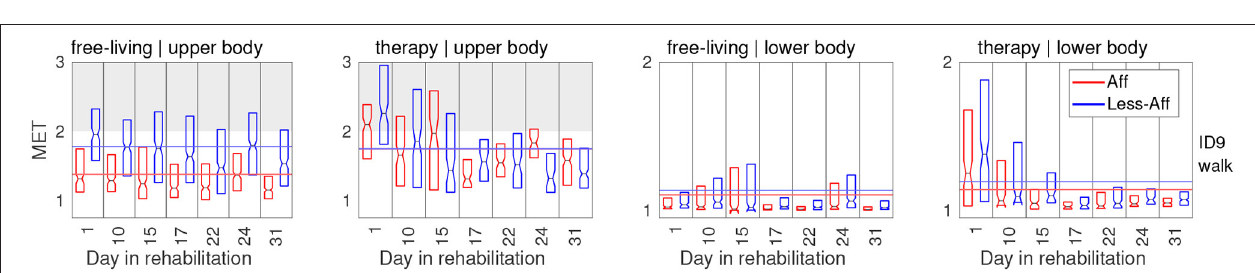
FIGURE 5 | Histograms of PA in MET equivalents for affected and less-affected upper and lower body for patient ID9. The distribution show PA derived from free-living and therapy during the complete rehabilitation period of patient ID9. PA distributions show a positive skew, indicating mostly light intensity, corresponding to sedentary behavior. The y-axis is log-scaled to emphasize small values in the distribution. Letters L , M , and V denote thresholds for light, moderate, and vigorous activity intensity, respectively.